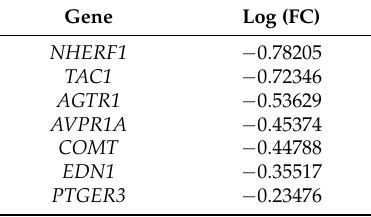
Table 1. Expression profile of genes annotated to regulation of excretion in cisplatin-resistant